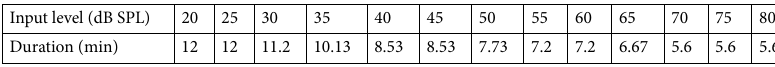
Table 1. Duration of EFR stimuli for each input level used in the NH